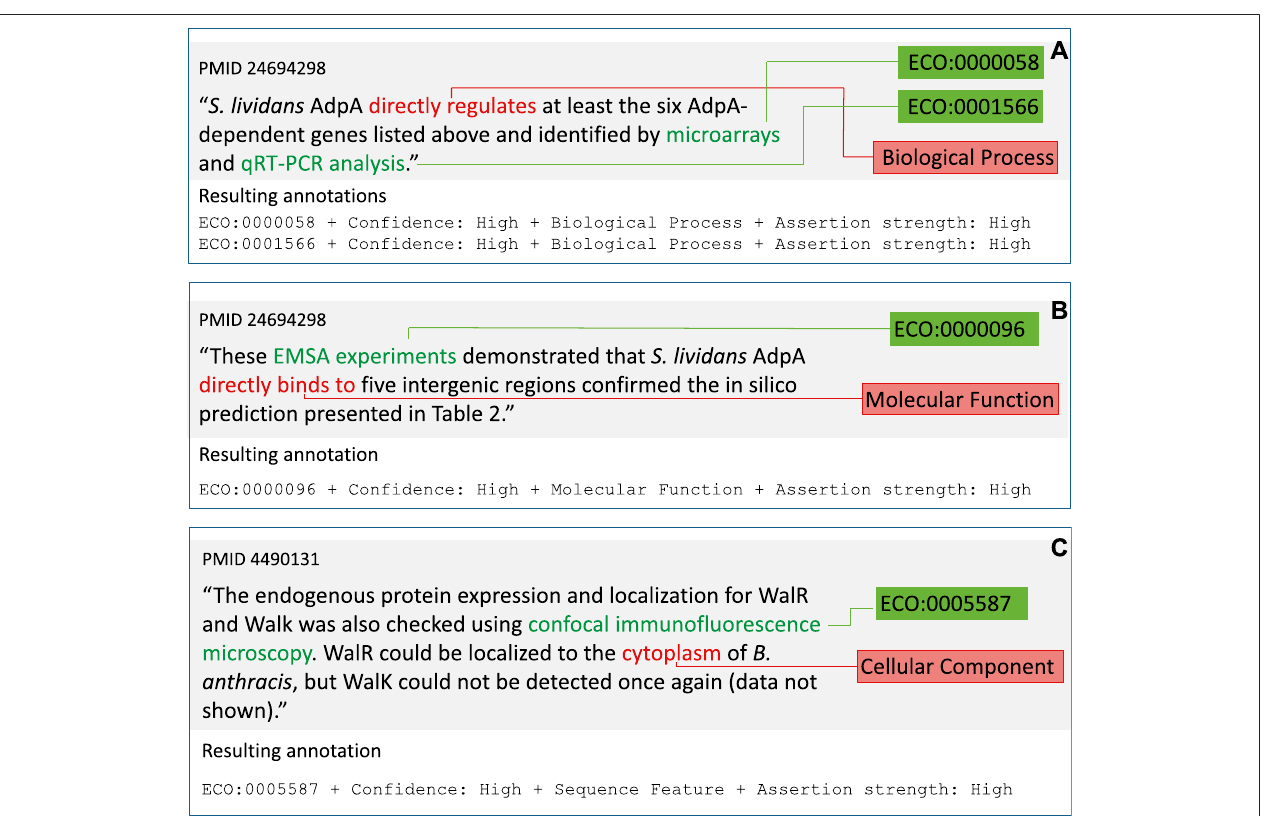
FIGURE2| Examplegeneproductannotations. (A) MultipleannotationsinonesentencewithBiologicalProcesscategory. (B) AnnotationwithMolecular Function category. (C) Annotation with Cellular Component category. Text segments in the sentence mapping to ECO terms (green boxes) are highlighted in green. Text segments indicating the category of assertion (red boxes) are highlighted in red. The ECO term, ECO mapping con fi dence, Category, and Assertion Strength are displayed underneath the annotated text.